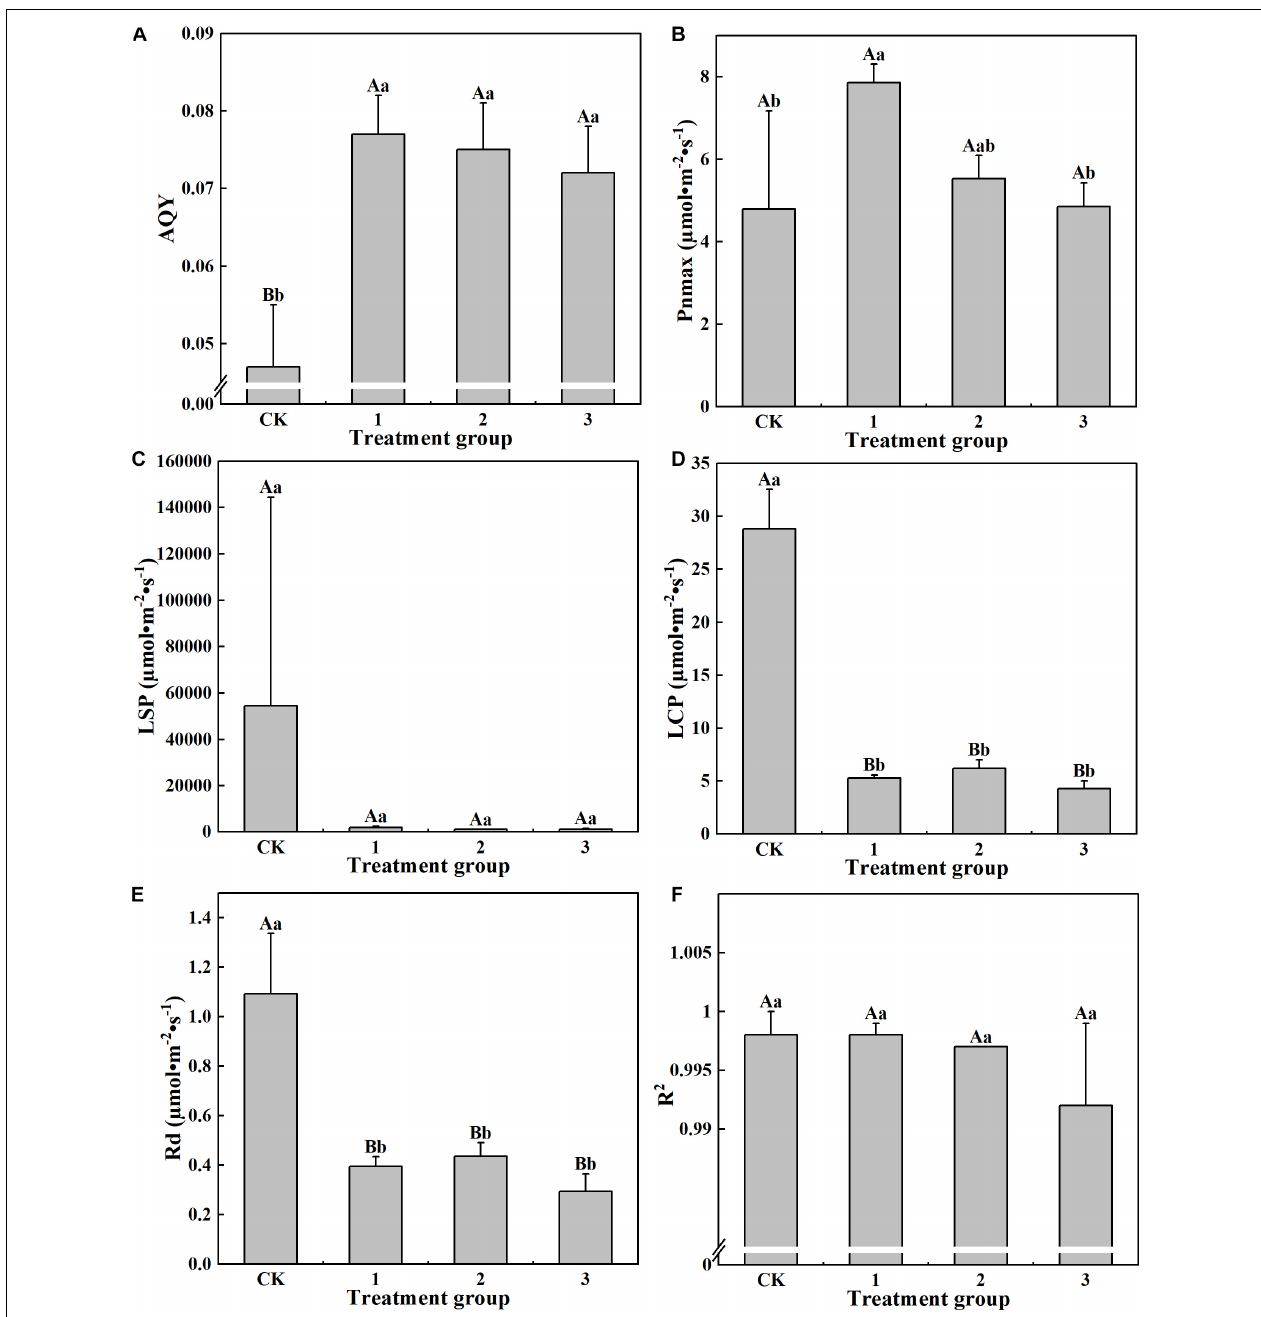
FIGURE 4 | The effect of different treatments on the Photosynthetic parameters of Horsfieldia hainanmensis The uppercase letters in the figure indicate P < 0.01, and the lowercase letters indicate P < 0.05, which, respectively, indicate extremely significant and significant differences (A–F) , respectively, represent. The apparent quantum efficiency (AQY) Light -saturated net Photosynthetic rate (Pnmax) light saturation point (LPS) compensation point (LCP), dark respiration rate (Rd) and coefficient of determination (R 2 ) of the influence of different light transmittance on Horsfieldia hainanmensis .